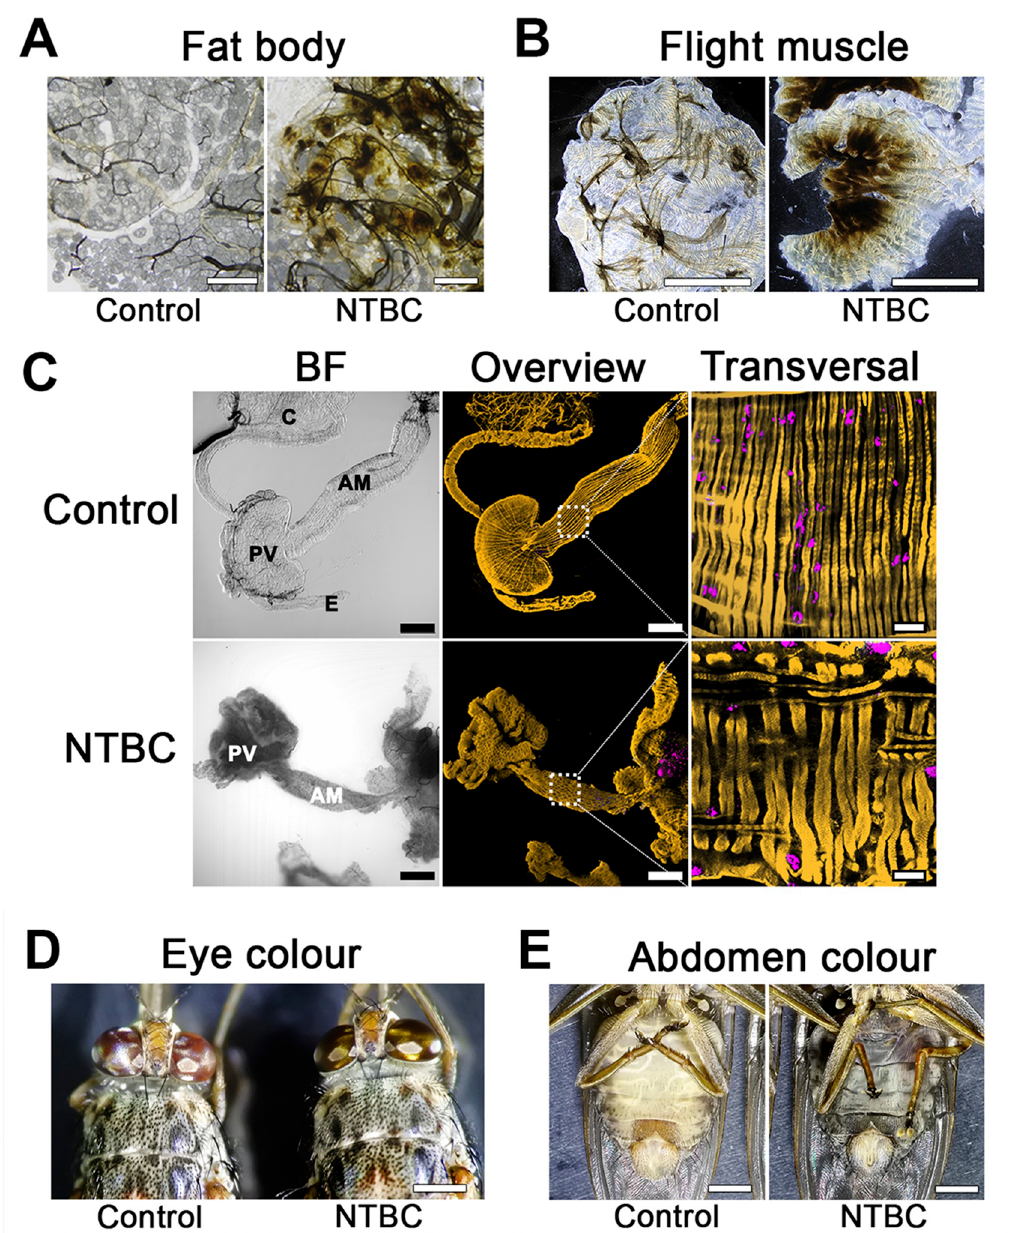
Fig 2. Tsetse phenotypes observed upon NTBC treatment. (A) Fat body. Scale bars = 100 μ m (control) and 80 μ m (treated). (B) Flight muscle. Scale bars = 1 mm. (C) Bright field (left) and fluorescence 3D-reconstructed (middle) overviews of the anterior midgut (AM), proventriculus (PV), crop (C), and oesophagus (E) from tsetse fed either without (Control) or with NTBC. Fluorescence channels merge SiR-actin staining (yellow) and DAPI (magenta). Scale bars = 200 μ m (100 × ). Detailed sections (right) of transversal muscular fibres from the outer muscular tissues in the anterior midgut region. Scale bars = 20 μ m (630 × ). (D) and (E) Death phenotype. Scale bars = 1 mm. Flies are already dead and the abdomens are “liquified”, black and filled with undigested blood. BF, brightfield; NTBC,